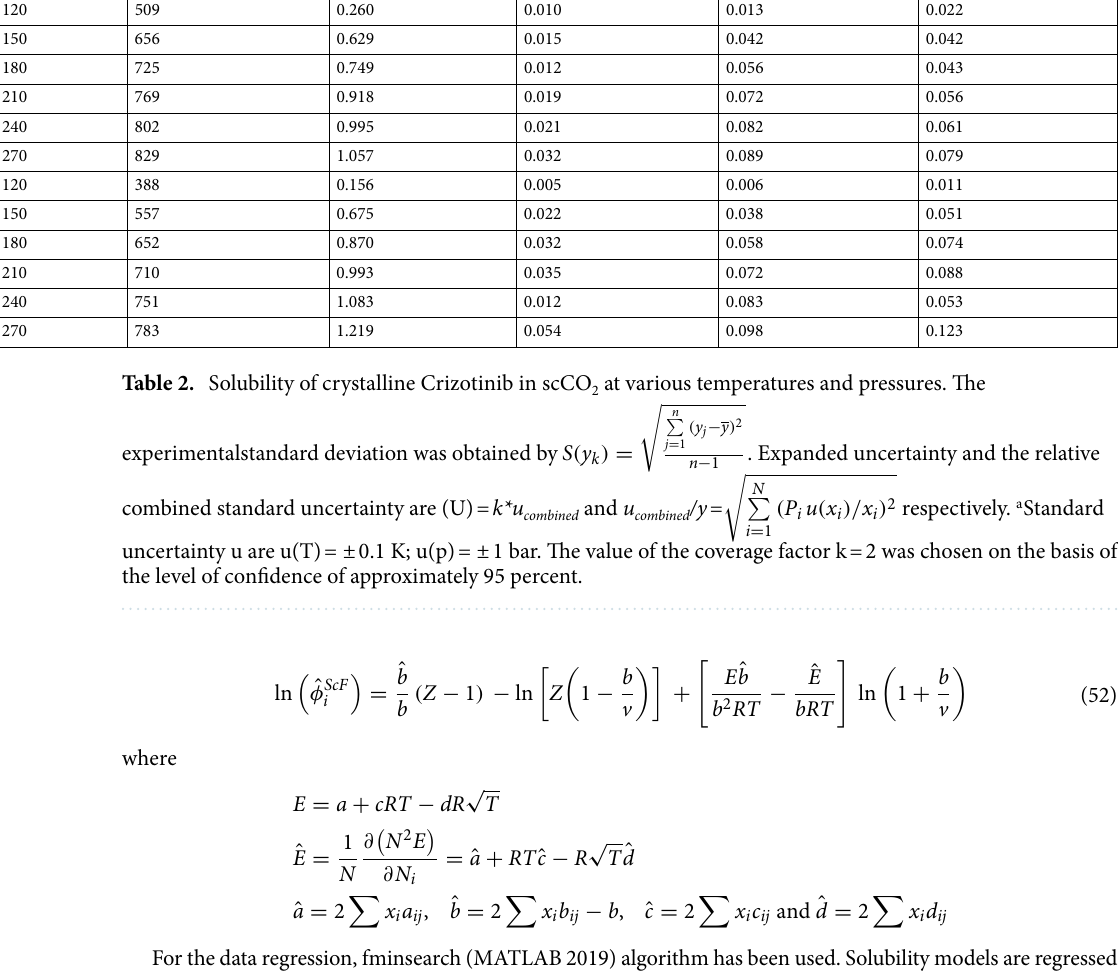
For the data regression, fminsearch (MATLAB 2019) algorithm has been used. Solubility models are regressed with the following objective function 55